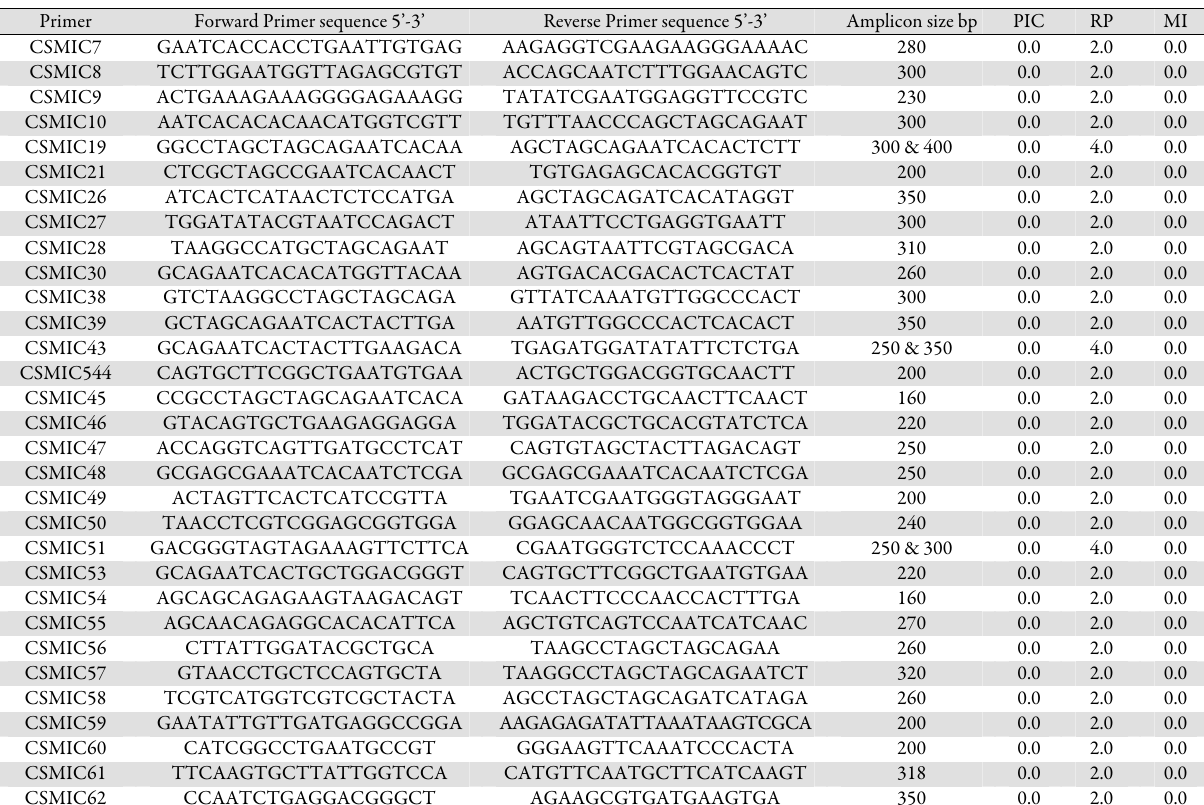
Table 2. Genetic diversity profile of 31 SSR primers across 31 selections of saffron